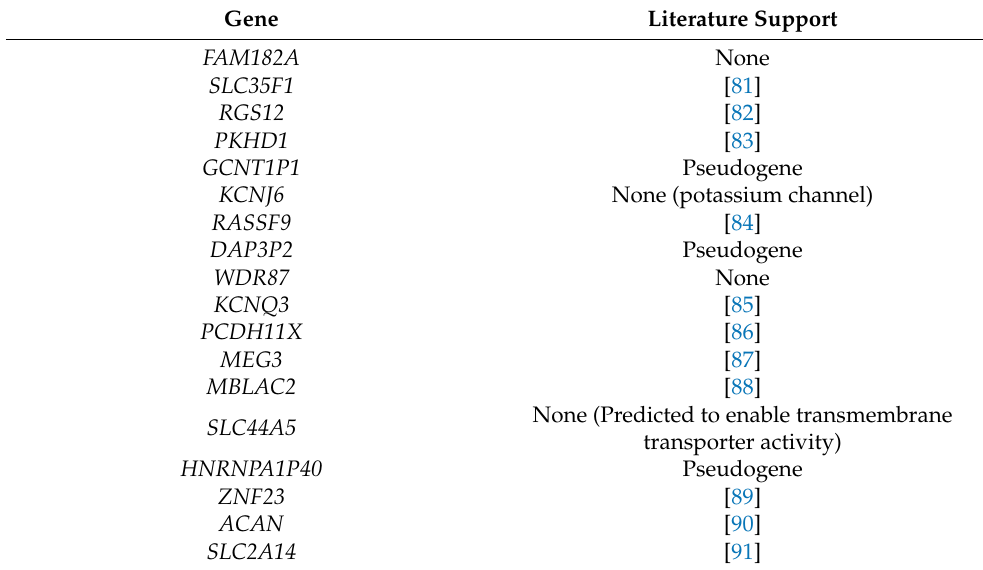
Table 4. Top Risk Decreasing Genes Identified by TCGA-READ Cox model: List of the top risk decreasing genes identified by our Cox model on the TCGA-READ